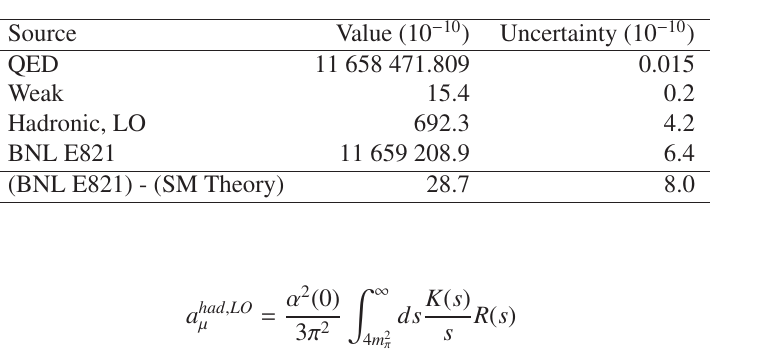
Figure 1. Lowest order Feynman diagram of vacuum polarization contributing to the muon anomaly. Table 1. Main contributions to a μ and their uncertainty. In the last line the E821 experimental result and the expectation in the Standard Model (SM) are compared